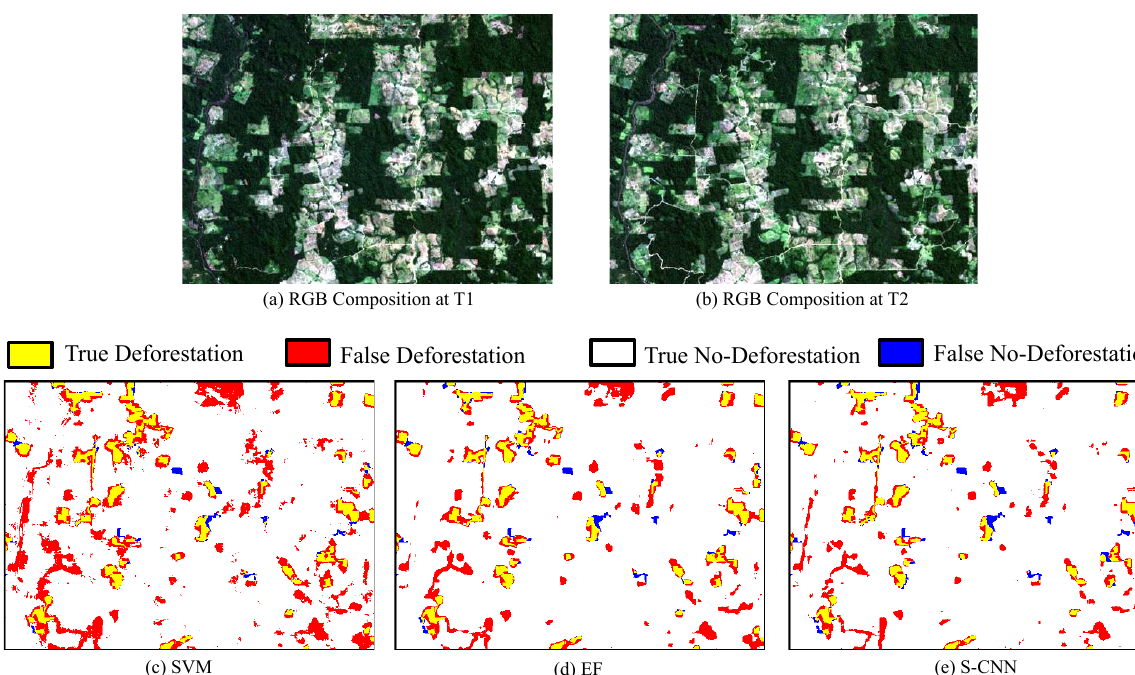
Figure 8. RGB composition and the change maps predicted by SVM, EF and S-CNN on the tile number six, which is part of the test